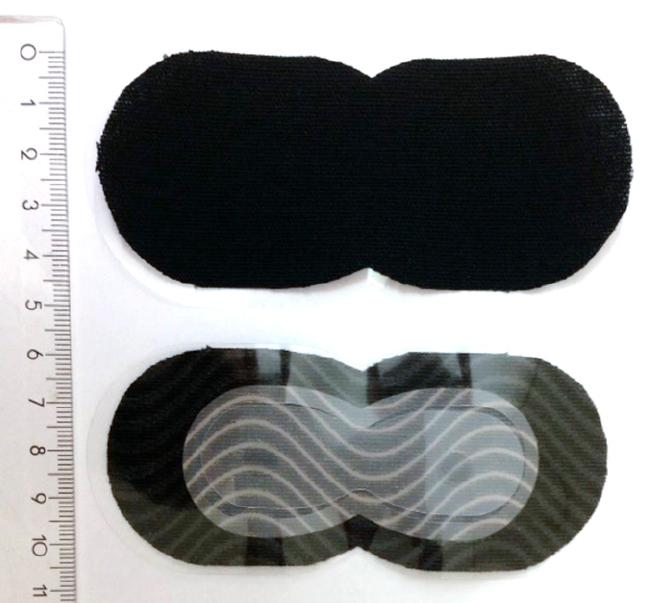
Figure 4. Passive